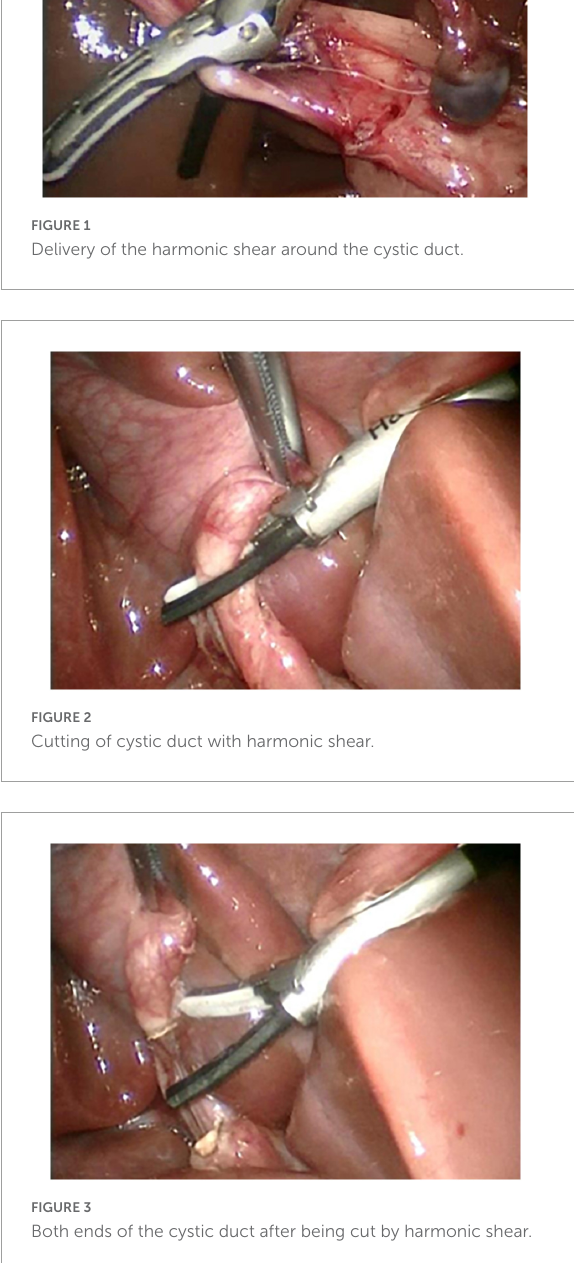
using HS was assessed by searching for a biliary leak or CBD stricture. Secondary outcomes in the form of operative time, time to start oral feeding, and discharge were recorded as